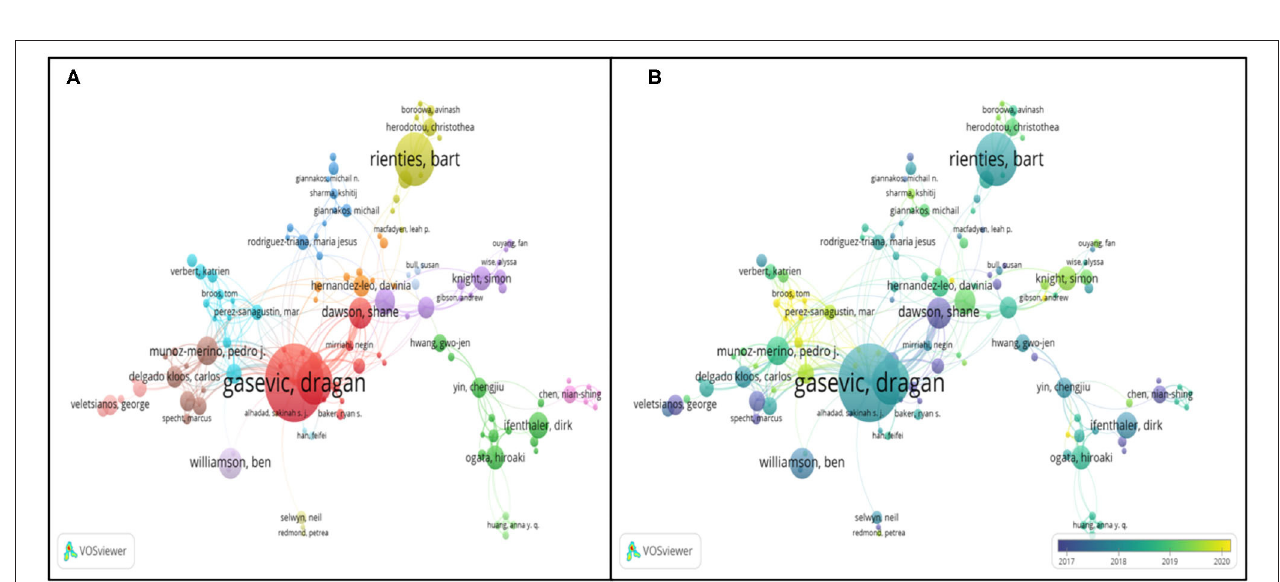
FIGURE 9 | Authors cooperative network in the realm of big data in education. (A) Network visualization map based on link weights; (B) Overlay visualization map based on link weights.